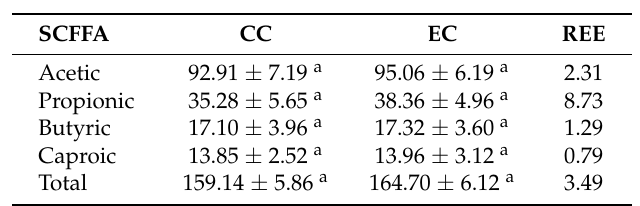
Table 6. Short chain free fatty acids (SCFFA) (ppm) of the control and the experimental Manchego cheese by the effect of the β -CD.